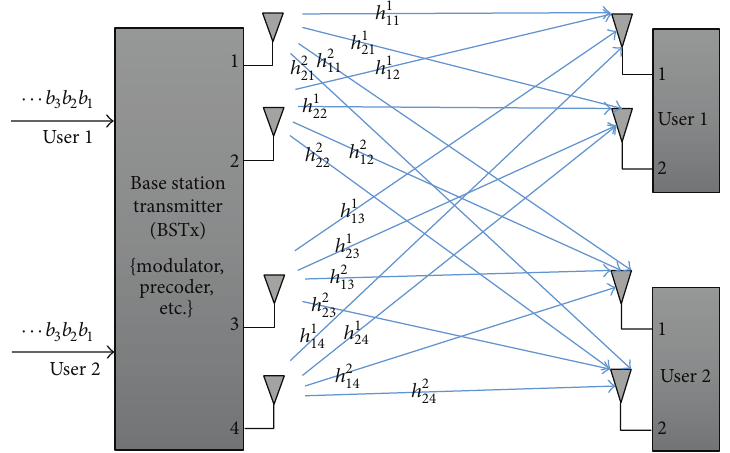
Figure 2: Example of SM for MU-MIMO system with 𝐾 = 2 , 𝑁 𝑡 = 4 , and 𝑁 𝑟 = 2